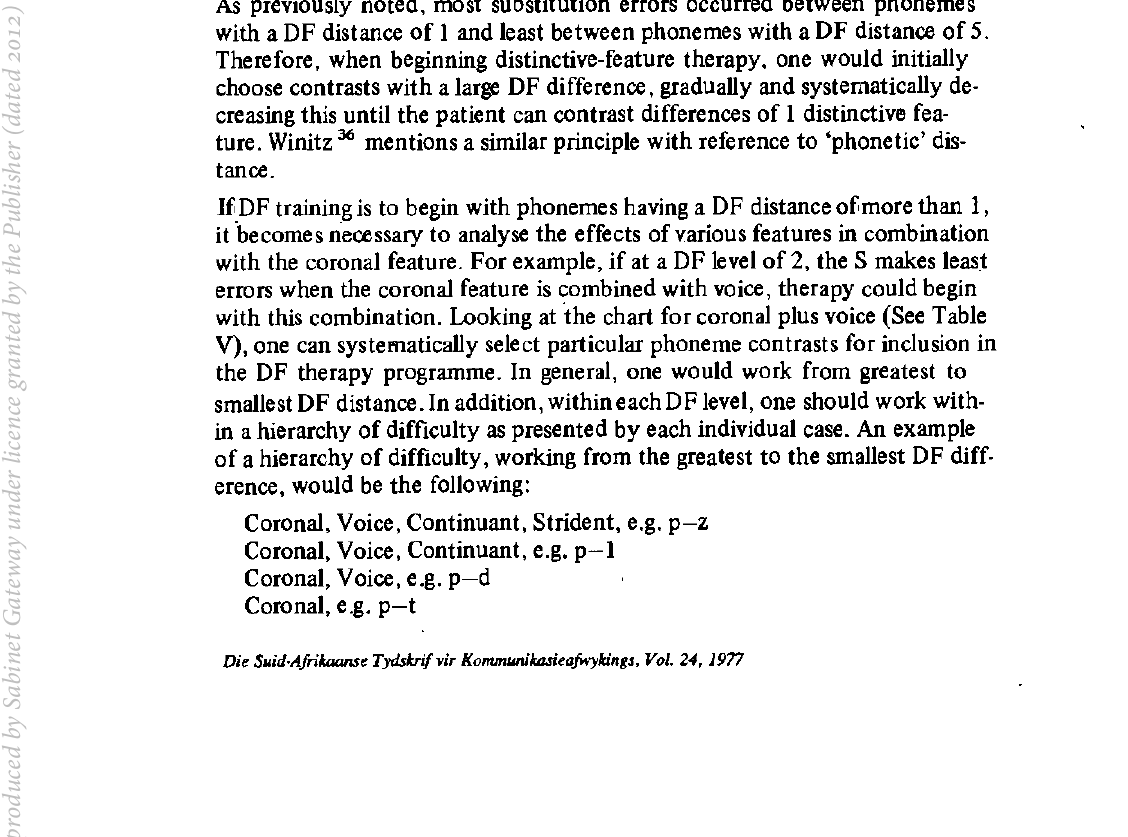
TABLE V: Example of part of the Coronal Feature Opposition